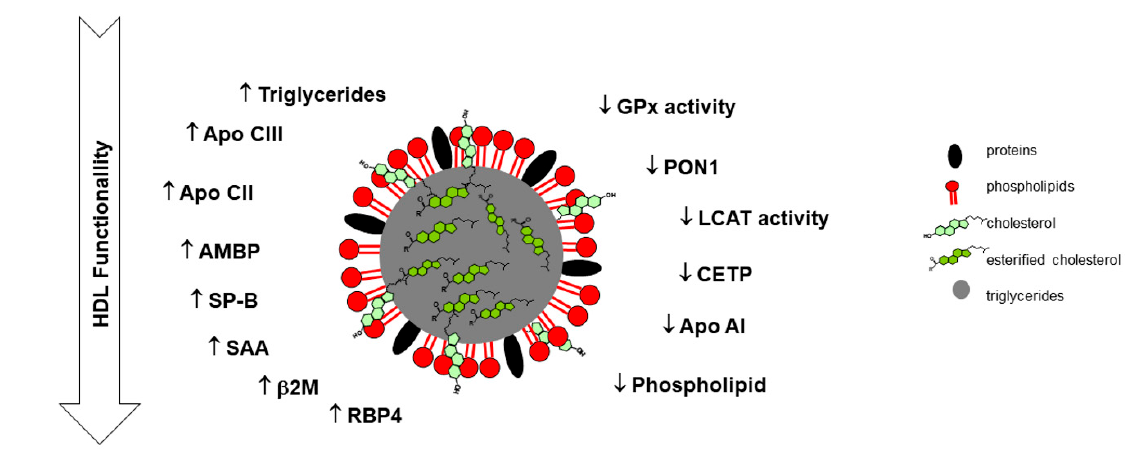
Figure 2. Schematic view of the major alterations in HDL composition in chronic kidney disease. (Apo, apolipoprotein; AMBP, α -1-microglobulin/bikunin precursor; β 2M, β -2-microglobulin; CETP, cholesteryl ester transfer protein; GPx, glutathione peroxidase; LCAT, lecithin–cholesterol acyltransferase; PON1, paraoxonase 1; RBP, retinol binding protein; SAA, serum amyloid; SP-B, surfactant protein B; ↑ , increases; ↓ , decreases).